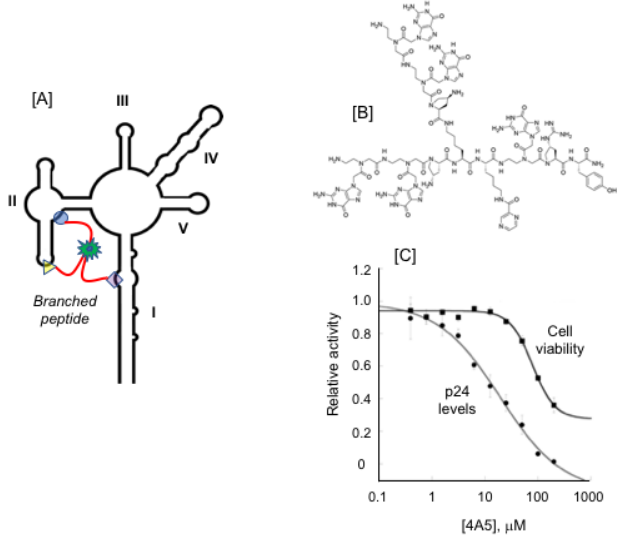
Figure 9. Restricting RRE conformational flexibility with multivalent branched peptides. ( A ) Cartoon depicting the branched peptide strategy, i.e., binding in a multivalent fashion to enhance affinity and selectivity toward the RNA target. ( B ) Structure of branched peptide 4A5. ( C ) Inhibition of Rev-RRE function in vivo using HEK 293T cells transiently transfected with a Rev-expressing plasmid and a CMV promoter-driven GagPol-RRE plasmid. Modified from Dai et al. [77].